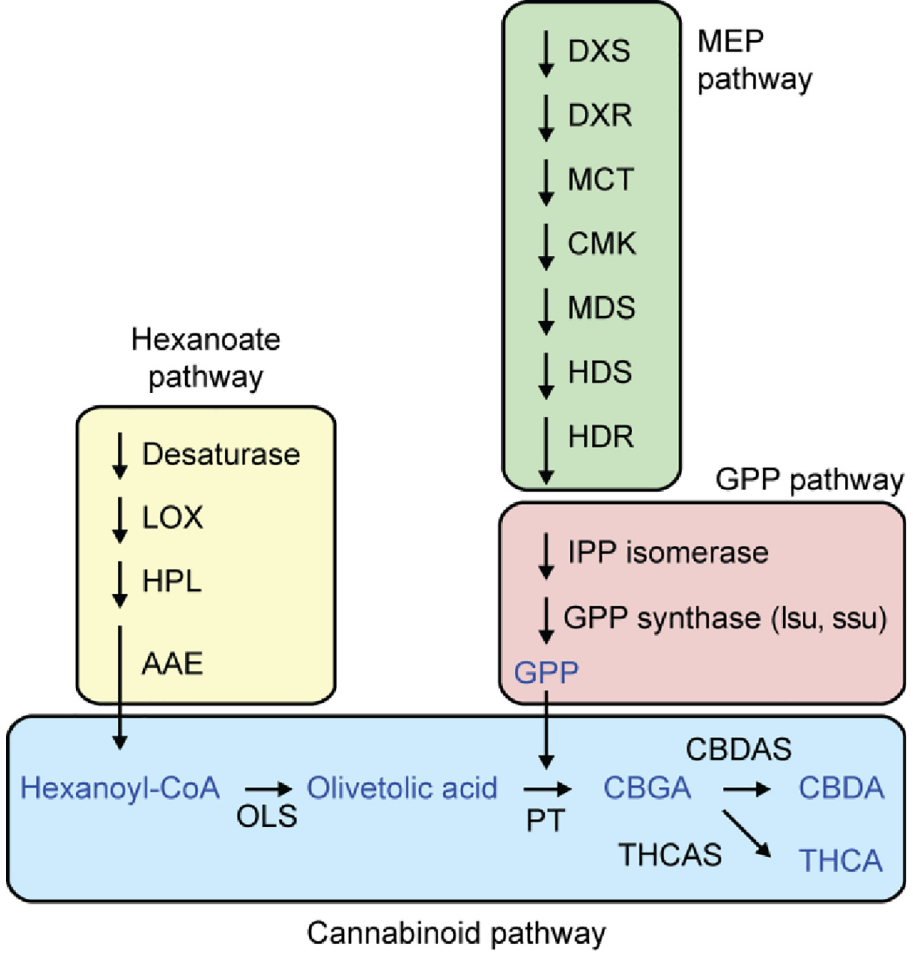
Fig 1. Overview of the cannabinoid biosynthesis pathways. Modified from van Bakel et al . (2011) [24].